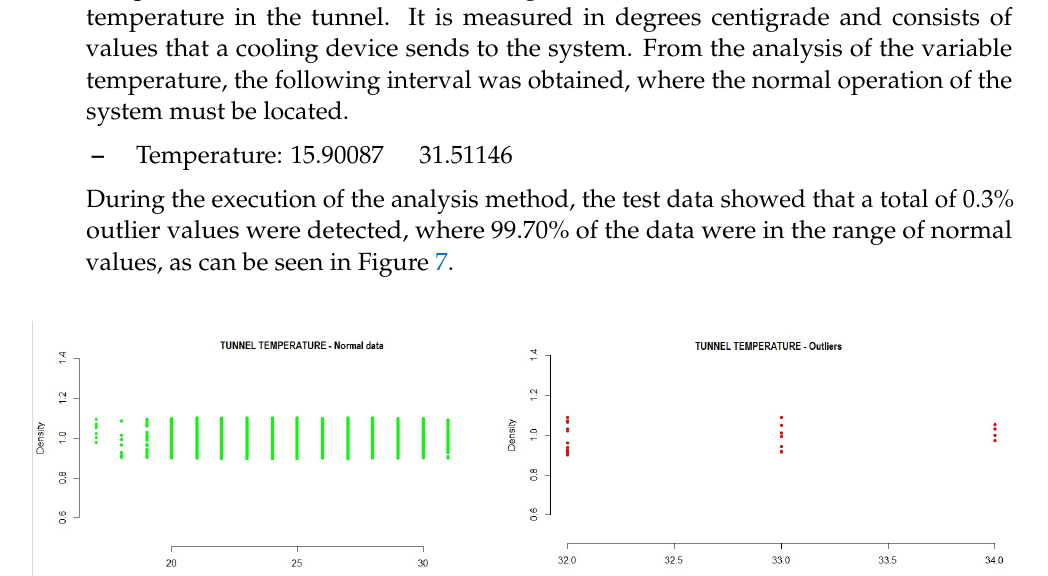
Performance Applying the New Mean of Distances to Local Transilience Outlier